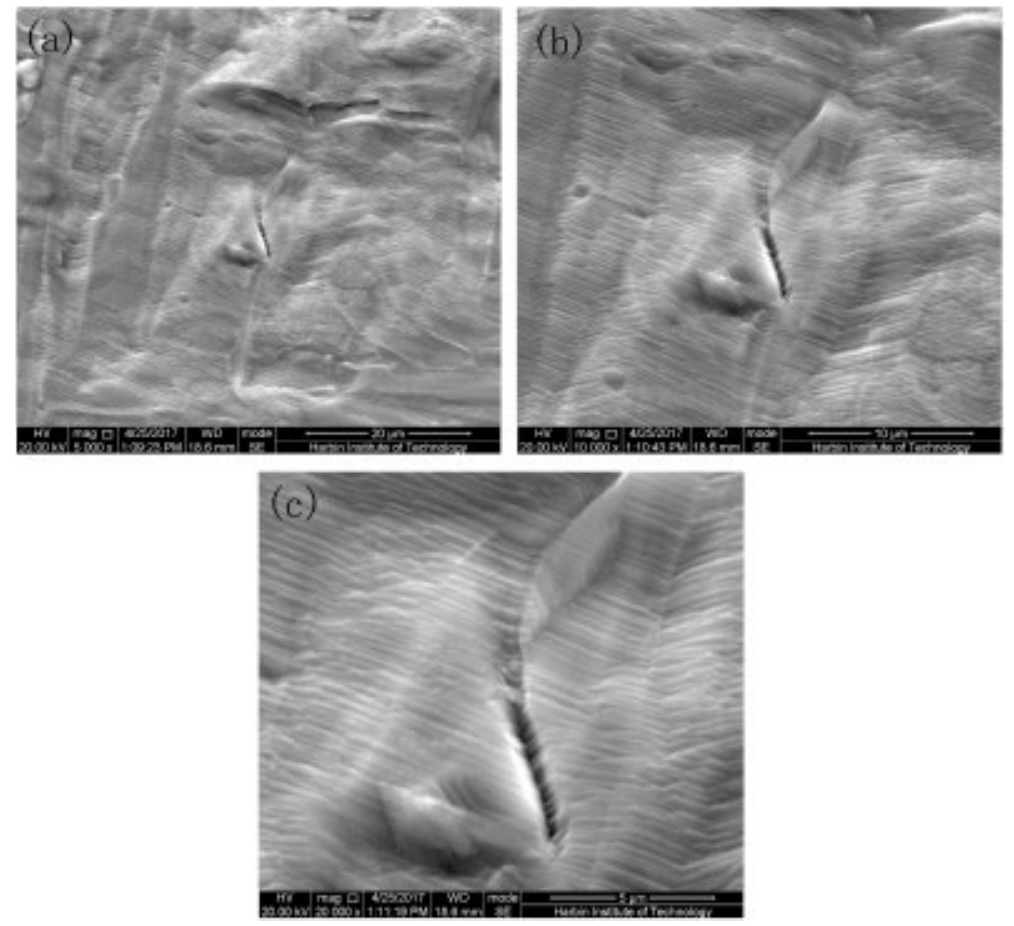
Figure 7. Typical morphology of microcracks of damaged titanium alloy sheet after high temperature treatment. ( a – c ) are Magnified 5,000, 10,000 and 20,000 times SEM image,